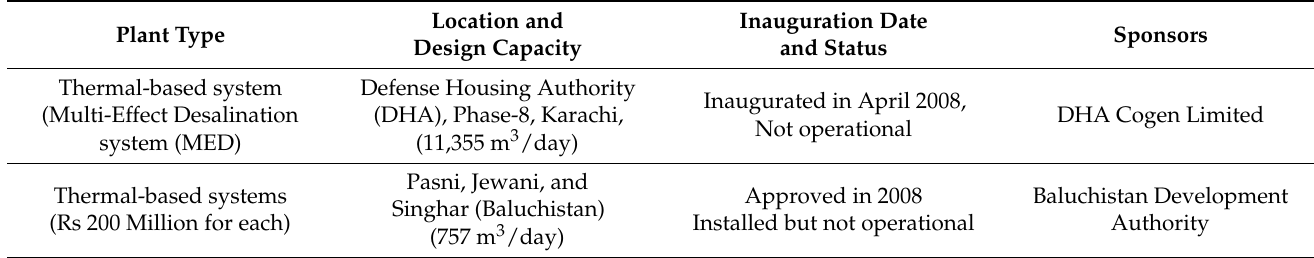
Table A4. Current status of desalination plants in Pakistan